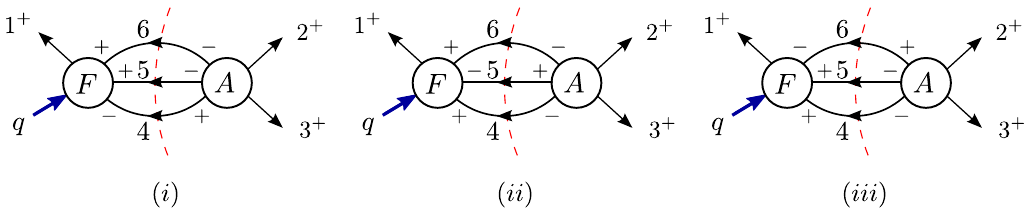
Figure 9 . Triple cut of the two-loop form factor in the s 23 -channel with only gluons running in the loop: F MHV (cid:2) A MHV .